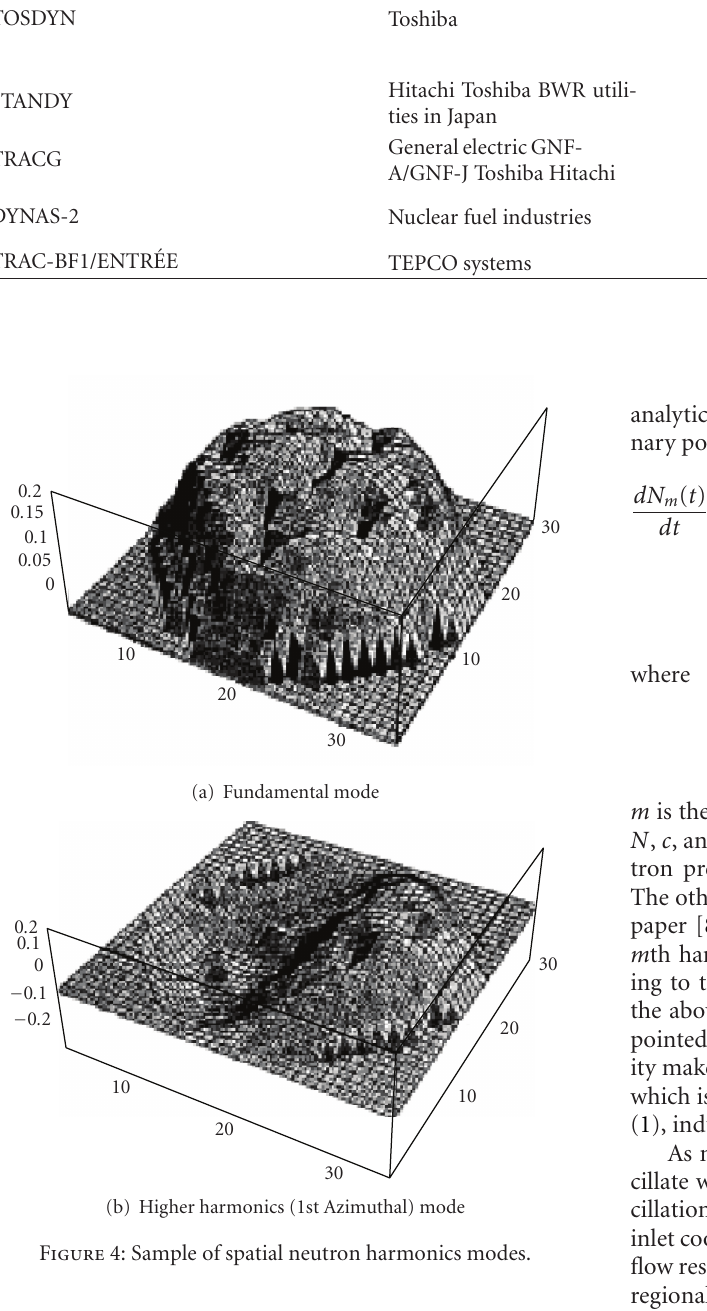
neutronic and thermal-hydraulic oscillation can be individ- ually excited in two halves of a core with an out-of-phase mode. Previous researchers proposed that the regional insta- bility is equivalent to the oscillation of the higher harmon- ics (1st azimuthal mode) of the neutron flux